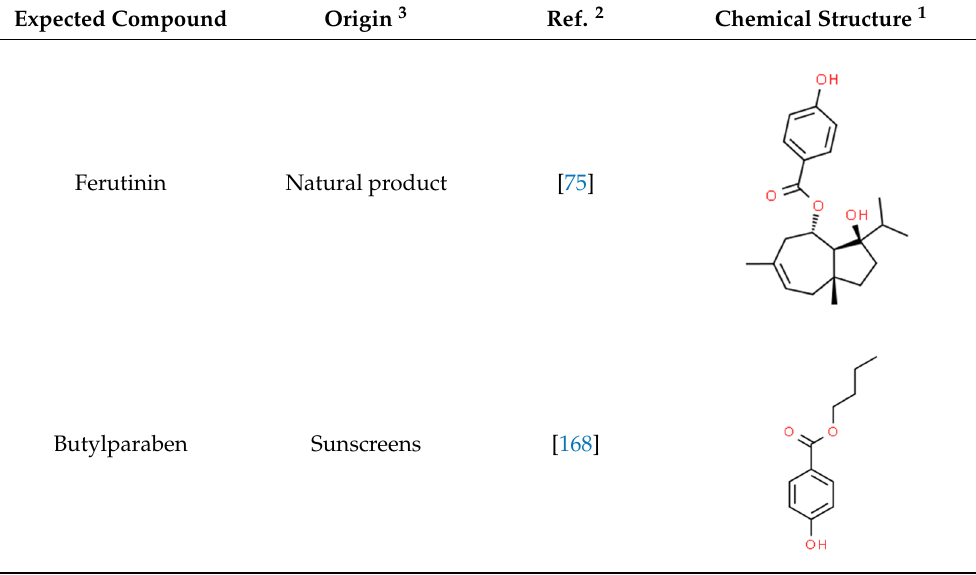
Table 6. Detected xenoestrogens in